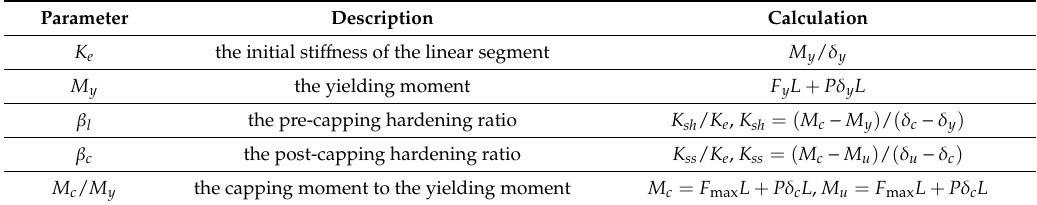
Table 3. Definition and determination of the tri-linear LP model